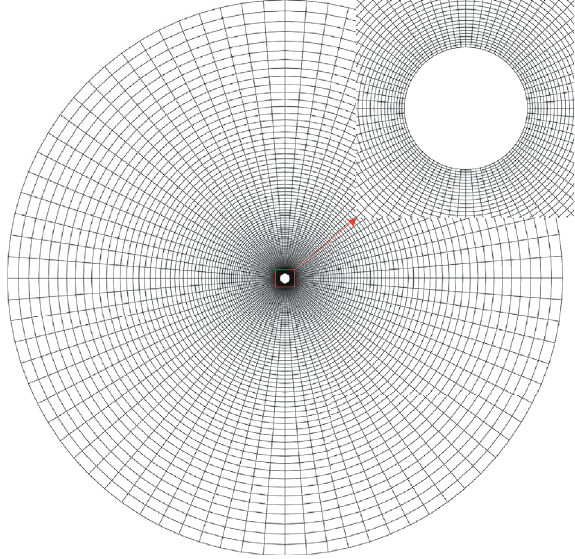
Figure 2: Geometry model and its